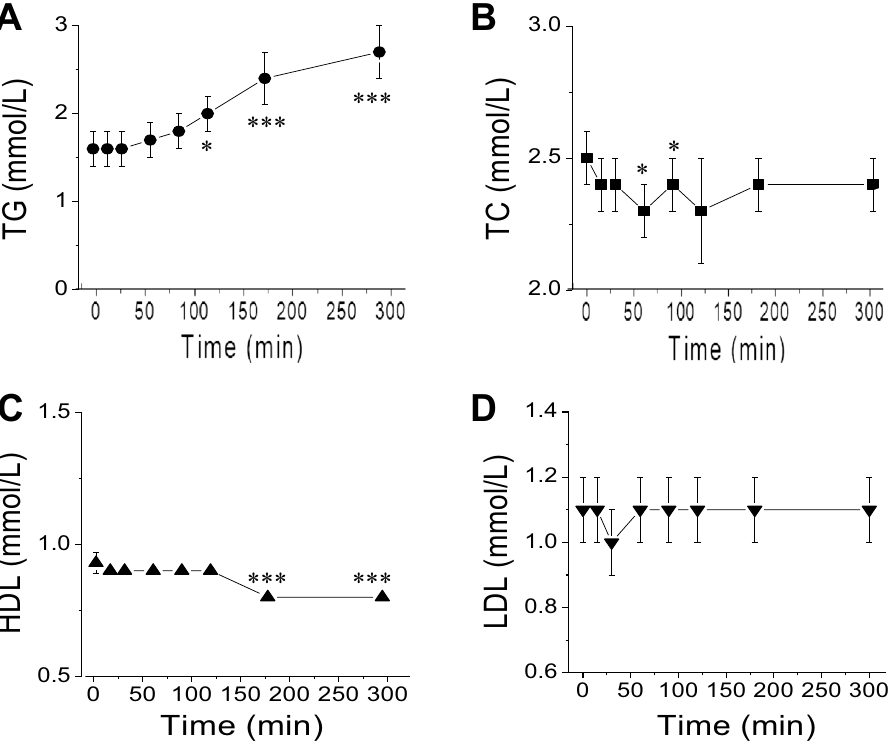
Figure 2. Time courses of the changes of plasma TG, TC, HDL and LDL following nasogastric meal administration at the time of 0 min. ( A – D) are their concentration changes, respectively. Values are means ± SEM (n = 16). For the plasma TG and HDL responses to the MMTT, there were significant time effects (RM One Way ANOVA; * p < 0.05; *** p < 0.001; vs the baseline time 0) by Dunnett’s multiple comparisons test. For the plasma TC and LDL responses, there were no significant time effects ( p >